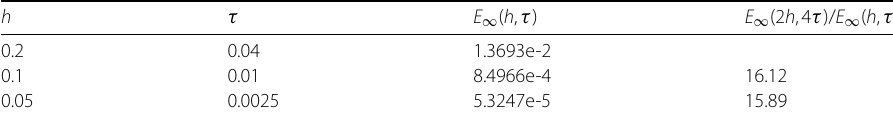
Figure 3 Discrete mass Q and energy E with h = 0.1, τ =